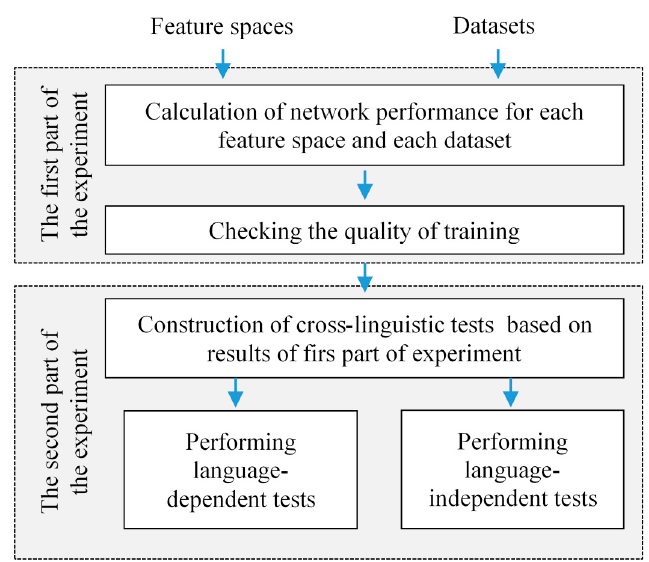
Figure 1. A block diagram of the experiment.